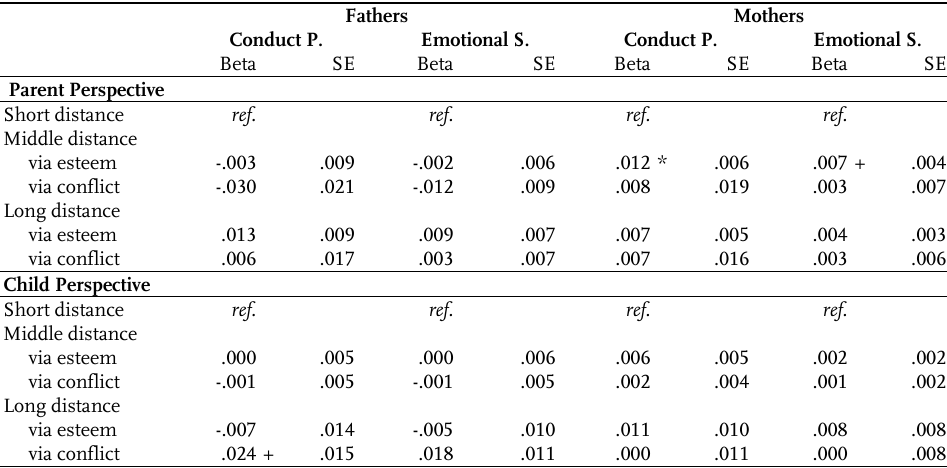
Table 6 : The indirect association between parental long-distance commuting and child well-being via the parent-child relationship (continued) Fathers Mothers Conduct P. Emotional S. Conduct P. Emotional S. Beta SE Beta SE Beta SE Beta